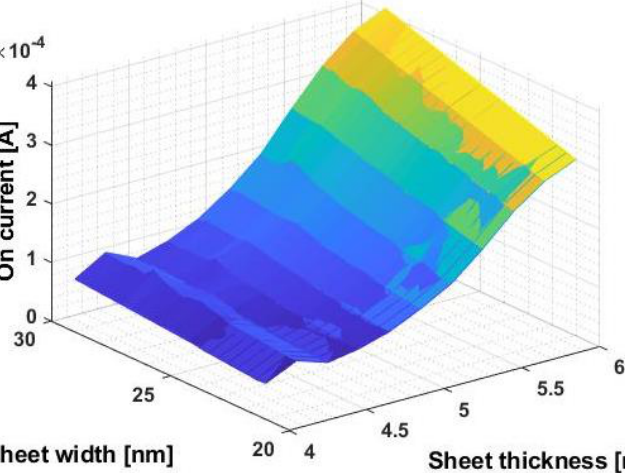
Figure 4. Nonlinear electrical characteristics of